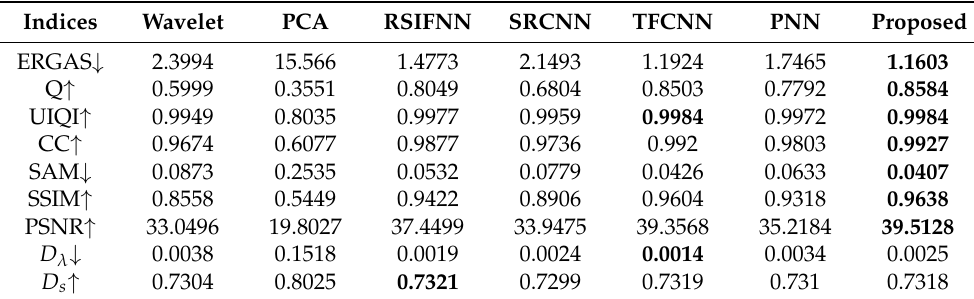
Figure 7. Comparison results obtained by different methods(downsampled GF-2 image of Qinghai Province, China). ( a ) LRMS image. ( b ) HRPAN image. ( c ) Reference MS image. ( d – j ) Pansharpening result of RSIFNN, Wavelet, PCA, SRCNN, TFCNN, PNN and the proposed method. Table 6. The quantitative statistics of distorted pixels of DL-based pansharpening methods (down- sampled GF-2 image).